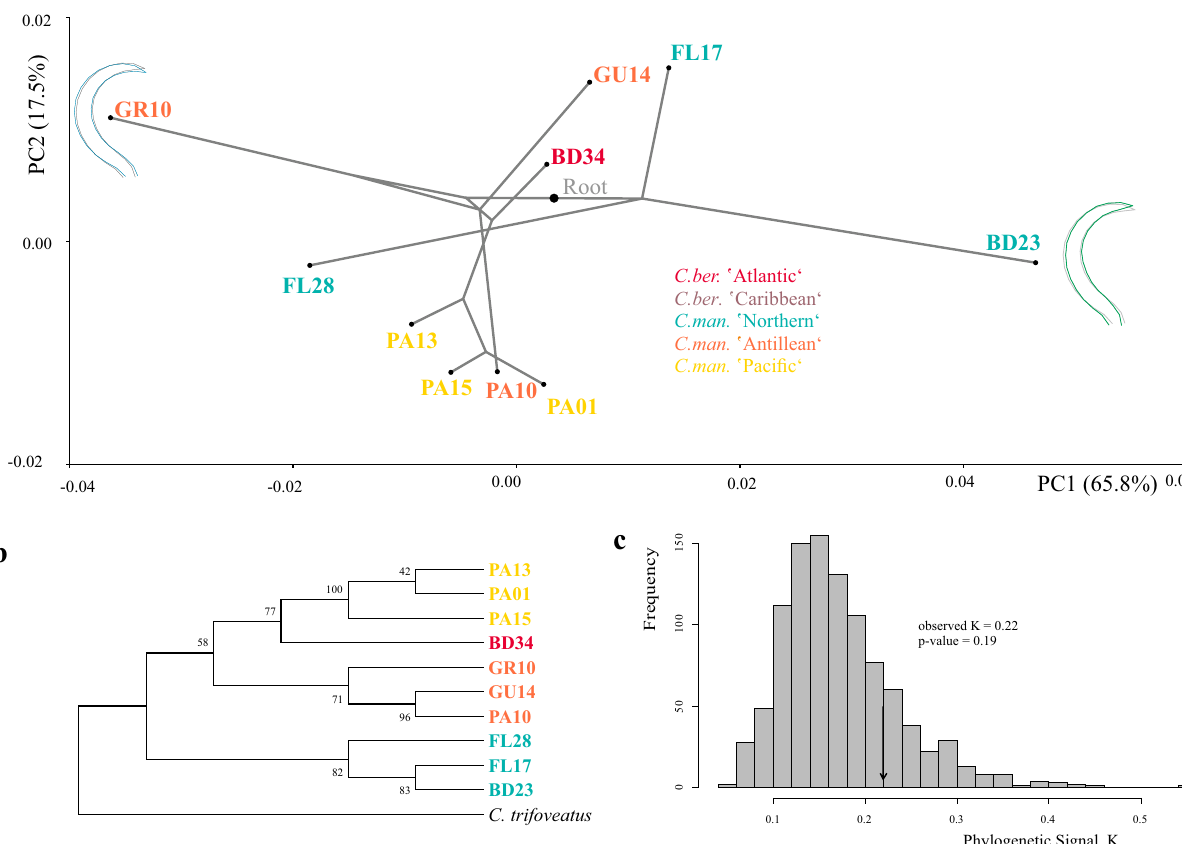
Figure 7. ( a ) Phylomorphospace showing changes in claw shape related to sampling location mapped onto phylogeny. Tips of the terminal branches are at the locations of population means with different colors for different genetic linages (colors are the same as in Fig. 1). ( b ) Neighbour joining tree based on COI sequences of representative individuals of 10 populations of the genus Carinozetes with C. trifoveatus as outgroup. ( c ) Histogram of Kmult values obtained from 999 permutations of the claw shape data on the tips of the phylogeny, with the position of observed value of Kmult